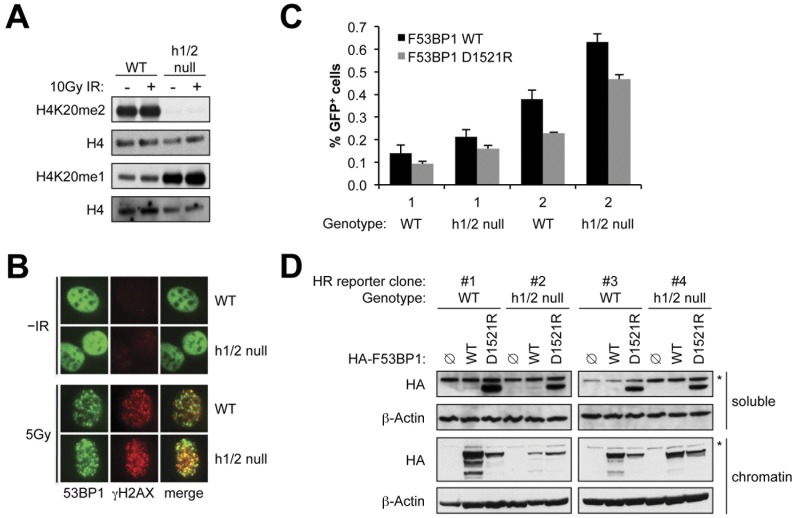
Histone H4K20me2 mark is dispensable for 53BP1-mediated DSB repair.
A) Immunoblotting for H4K20me2, H4K20me1, and H4 (loading control) in individually derived wild type (WT) and Suv4-20h1/2 null (h1/2 null) cell lines that received no treatment or 10 Gy of IR. B) 53BP1 and γH2AX focus formation 10 minutes after 5 Gy IR treatment of wild type and Suv4-20h1/2 null cells. C) I-SceI-induced HR frequencies (indicated by GFP+ products) in two independent wild type and Suv4-20h1/2 null HR reporter cell lines transiently transfected with HA-F53BP1 WT or the HA-F53BP1 D1521R mutant expression plasmids. Bars represent mean of triplicate samples. Error bars indicate s.e.m.. t test of F-53BP1 WT vs. D1521R: Clone 1 WT: not significant (NS); Clone 1 h1/2 null: NS;Clone 2 WT p = 0.025; Clone 2 h1/2 null: p = 0.027. D) Levels of transiently expressed HA-tagged F53BP1 proteins and β-actin loading control corresponding to the experiment in C in both the soluble and chromatin fractions. Note tight chromatin association of wt F53BP1 fragment and abundant soluble fraction of F53BP1 D1521R protein. *: background band.